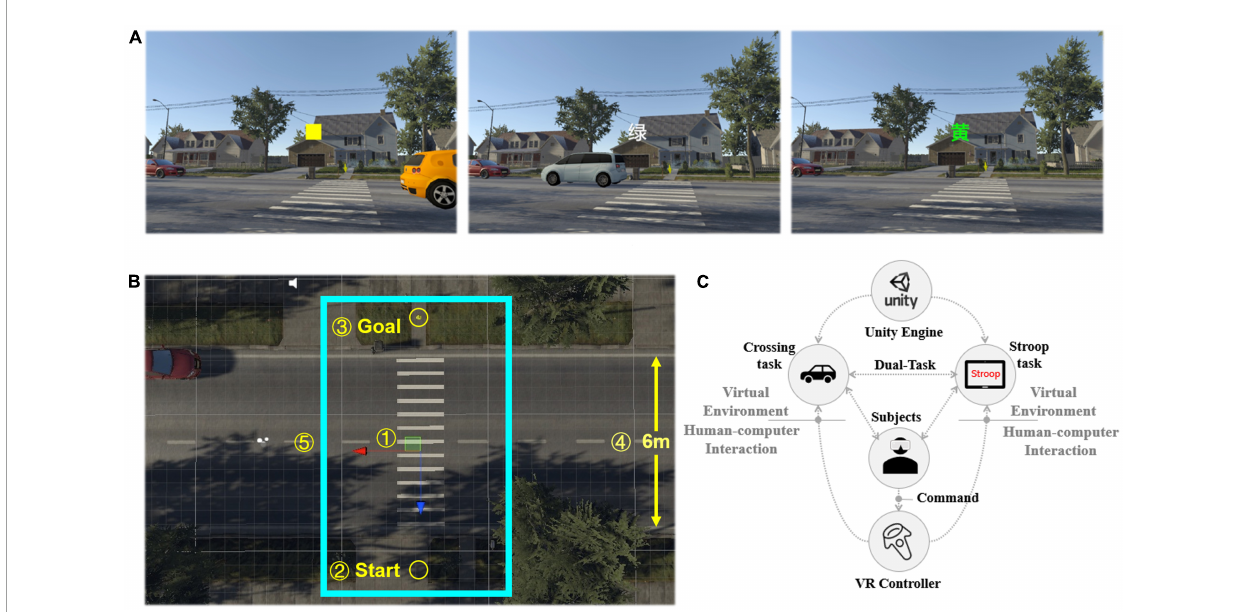
FIGURE2 Virtual scene overview. (A) Three examples of virtual environment. Left: VE of Dual-Task I with a color-matching task. Middle: VE of Dual-Task II with a word-matching task. Right: VE of Dual-Task III with an interference-matching task. (B) Schematic structure of the street scene. is the zebra crossing; is the start point; is the destination for crossing the street; indicates the width of the street; shows the area where participants are allowed to move. The red arrow in the figure is the orientation of the x -axis, while the blue arrow is the orientation of the y -axis. (C) System design.